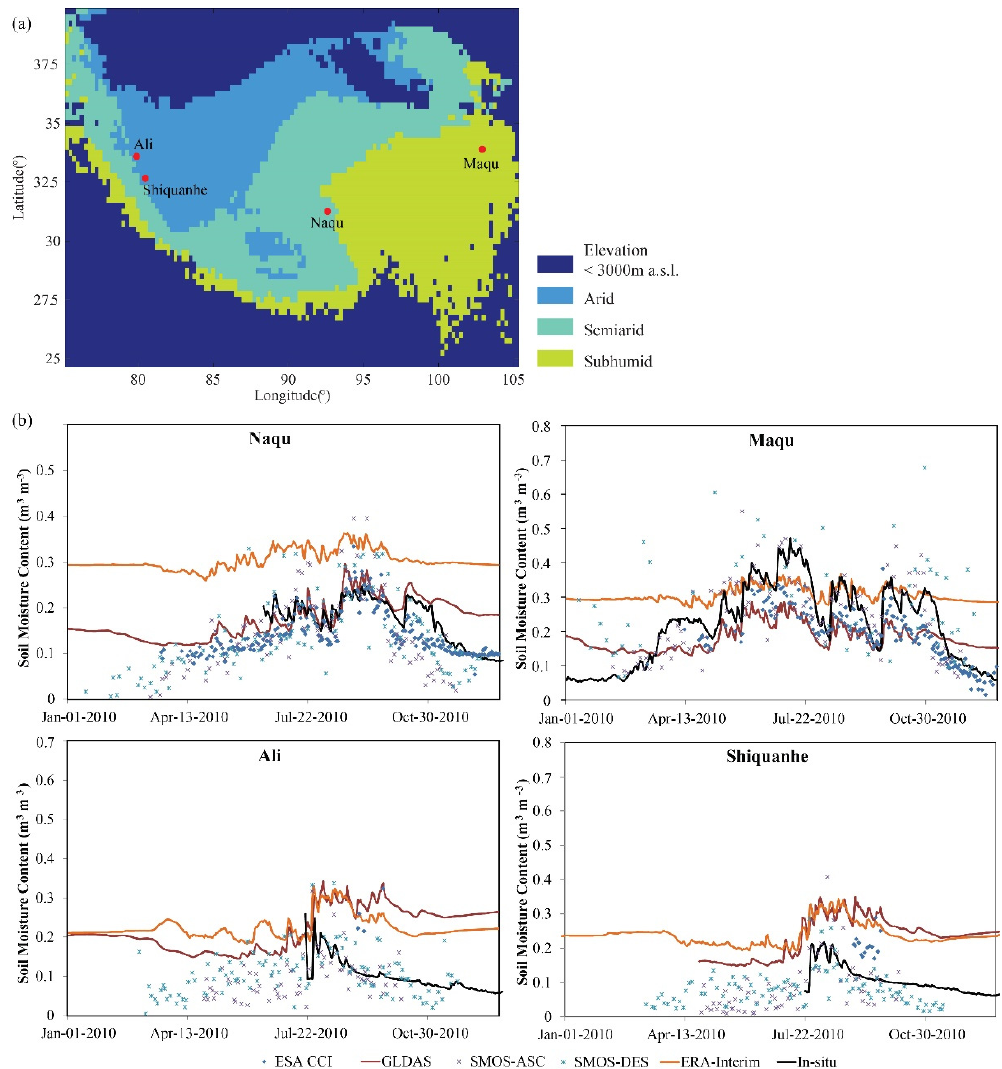
Figure 1. ( a ) Tibet-Obs networks are distributed under the three different climatic zones. The climatic zones over Tibetan Plateau were classified based on the FAO Aridity Index Map. The dark blue color represents the area around Tibetan Plateau, with elevation lower than 3000 m above sea level (a.s.l.); and ( b ) time series of satellite observed, LSM simulated and in situ measured SM for the Tibet-Obs sites: Ali, Maqu, Naqu, and Ngari-Shiquanhe.